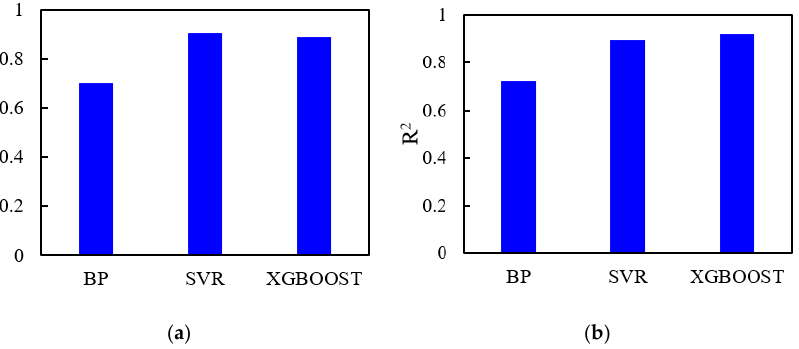
Figure 8. Comparison of algorithm prediction accuracy under different learning sample numbers: ( a ) n = 800; ( b ) n = 1896.